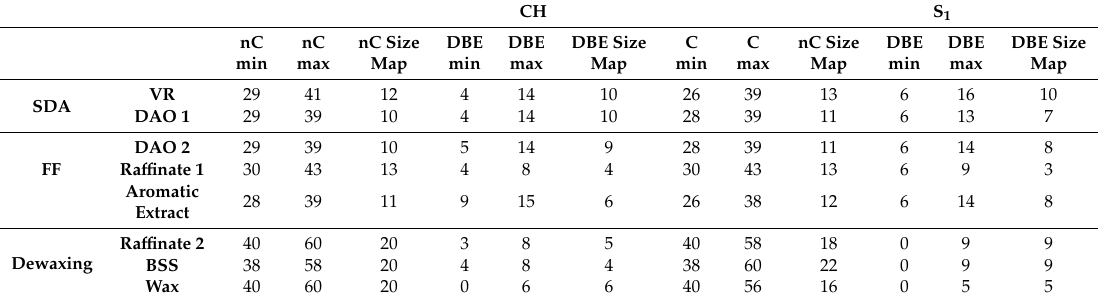
Figure 10. Minimum of DBE as a function of the log of viscosity for all the samples ( A ) except VR ( B ). Table 4. Carbon number and DBE min and max data extracted from HC and S 1 (Figures 7–9). CH S